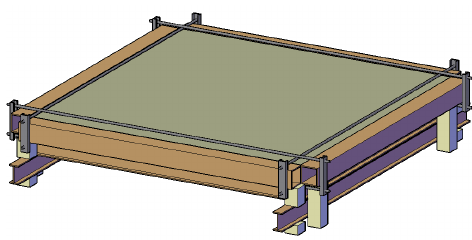
Figure 16. Protection of the slab against the action of the thrust force by means of a steel frame.